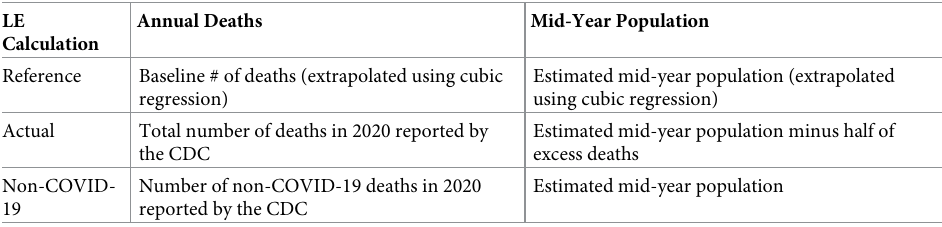
Table 2. Summary of the values used for life expectancy